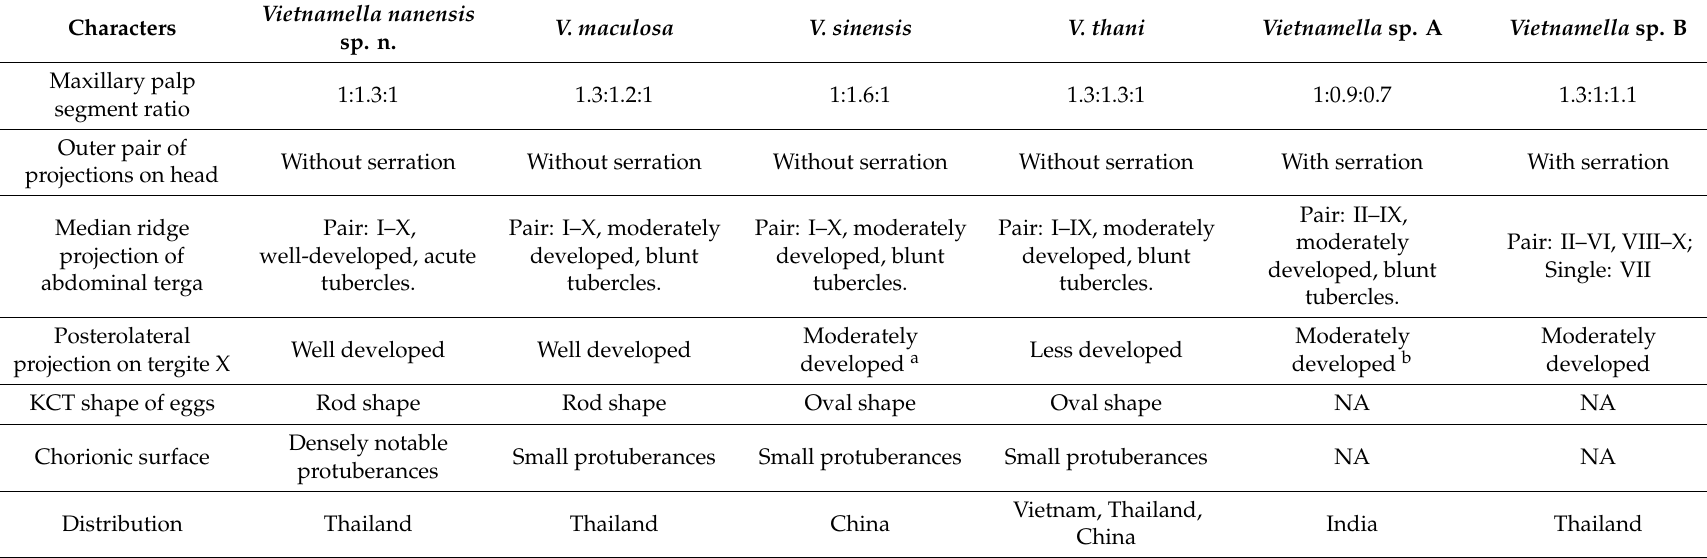
Table 3. Comparisons of known larvae and eggs of